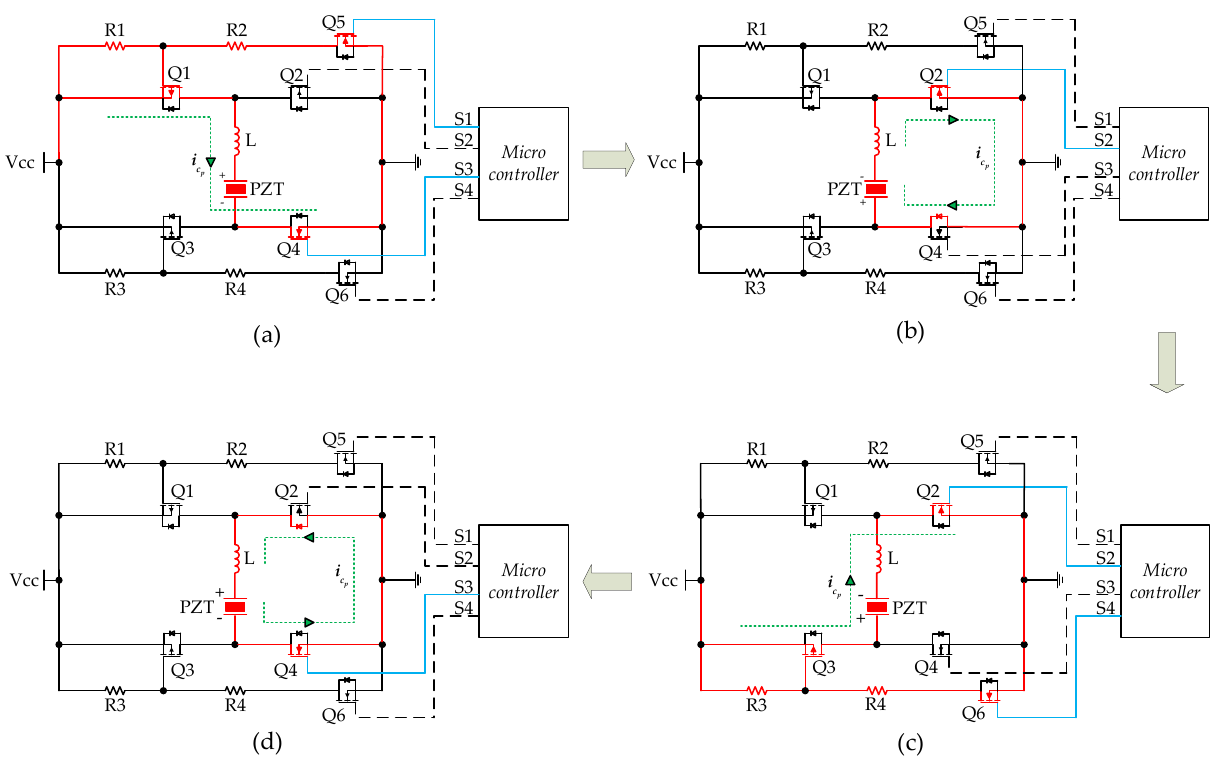
Figure 8. Driving process of the SID circuit, including four stages ( a – d ) in a cycle.